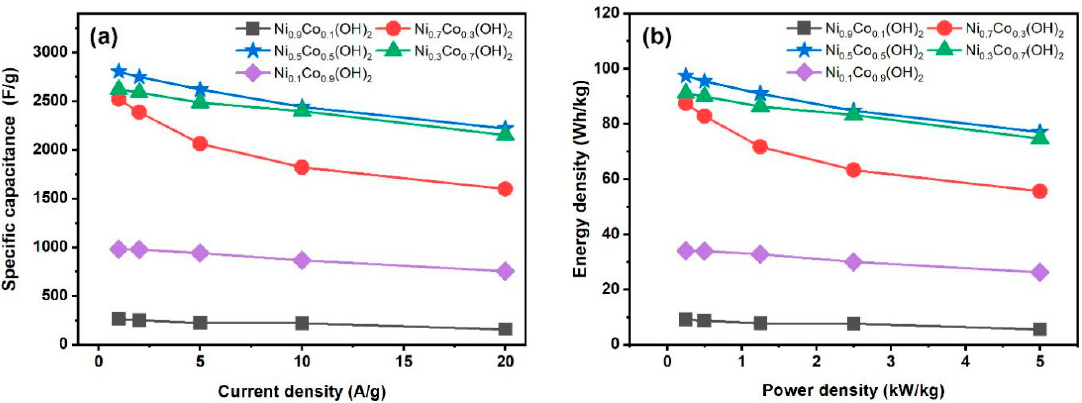
Figure 6. ( a ) Specific capacitances as a function of current densities and ( b ) Ragone plots of the Ni 1-x Co x (OH) 2 samples.